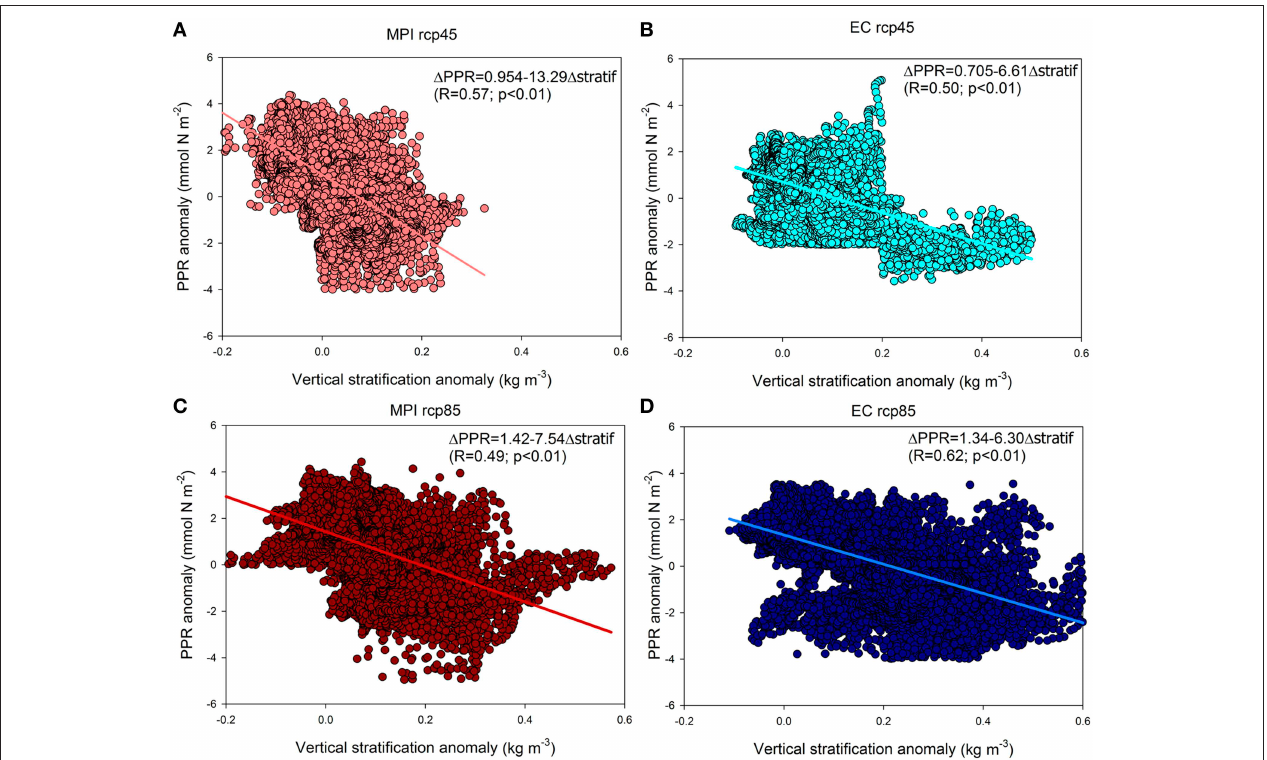
FIGURE 9 | Scatter plot of vertical stratification (density at 50m—surface density) anomalies vs. PPR anomalies in the different runs. (A) MPI rcp4.5, (B) EcEarth rcp4.5, (C) MPI rcp8.5, (D) EcEarth